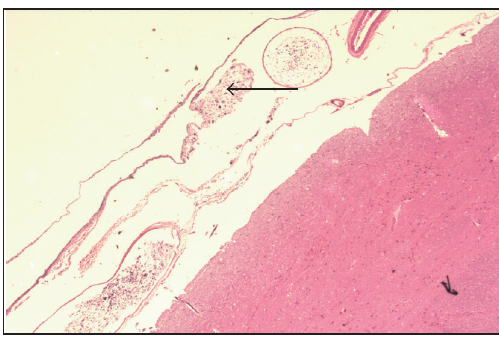
Figure 1: Gross postmortem image of mid brain showing thickened meninges.